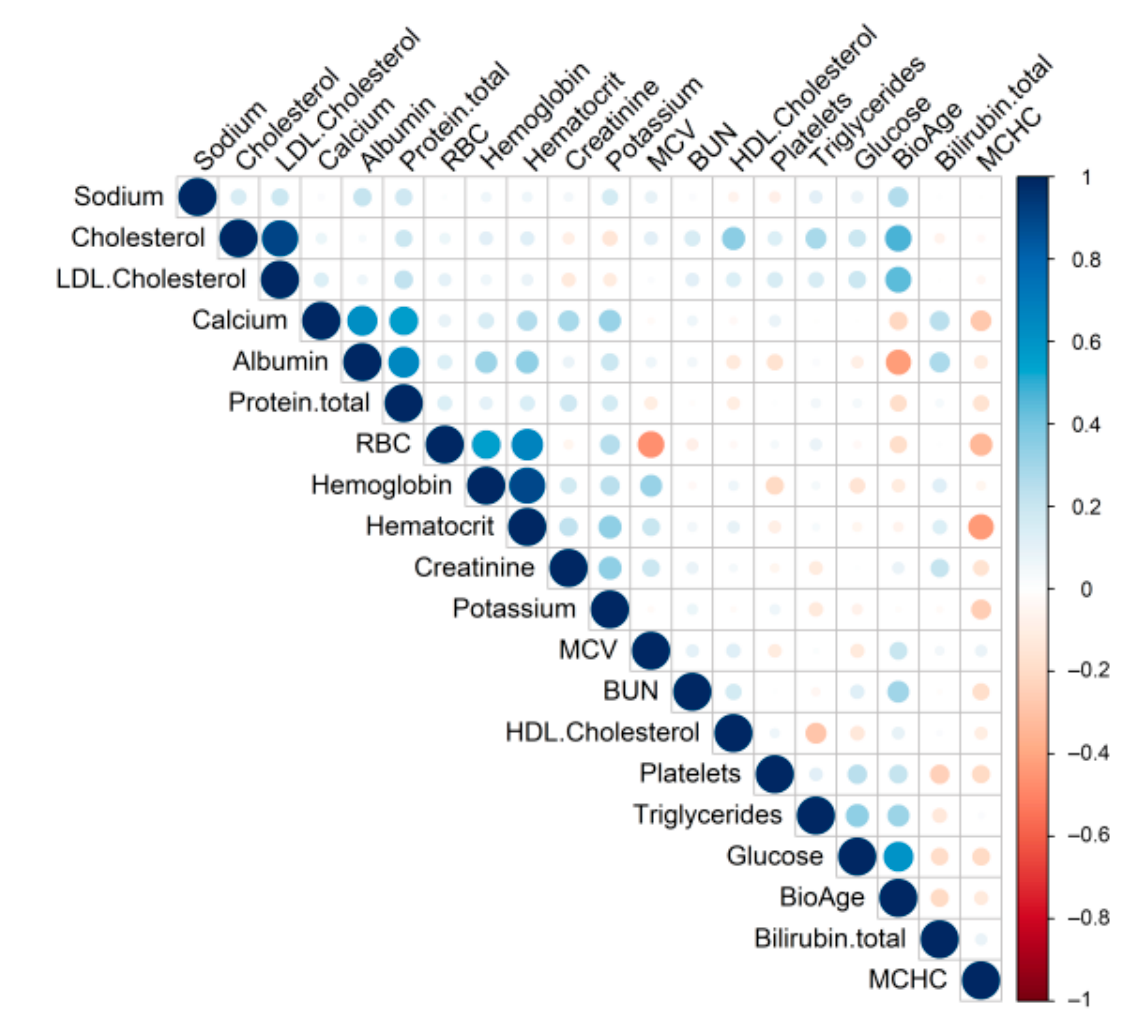
Figure 4. Correlation matrix of pair Spearman’s coefficients for biological age measurement blood markers.